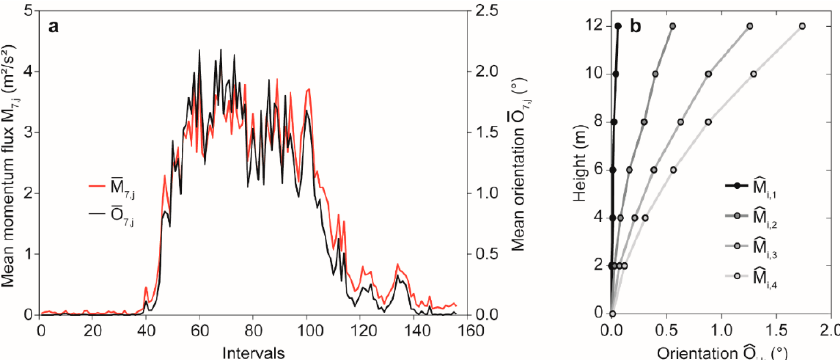
Figure 4. ( a ) Mean momentum flux at canopy height ( 𝑀(cid:3365) (cid:2875),(cid:2920) ) and mean orientation at ℎ (cid:2875) = 12 m ( 𝑂(cid:3364) (cid:2875),(cid:2920) ) in 156 irregular intervals on 30 January 2019; ( b ) mean orientation ( 𝑂(cid:3552) (cid:2919),(cid:2921) ) at ℎ (cid:2869) = 0.1 m to ℎ (cid:2875) = 12 m in four classes of mean momentum flux calculated at canopy height ( 𝑀(cid:3553) (cid:2919),(cid:2869) : 𝑀(cid:3365) (cid:2919),(cid:2920) < 1.0 m²/s², 𝑀(cid:3553) (cid:2919),(cid:2870) : 1.0 m²/s² ≤ 𝑀(cid:3365) (cid:2919),(cid:2920) < 2.0 m²/s², 𝑀(cid:3553) (cid:2919),(cid:2871) : 2.0 m²/s² ≤ 𝑀(cid:3365) (cid:2919),(cid:2920) < 3.0 m²/s² and 𝑀(cid:3553) (cid:2919),(cid:2872) : 𝑀(cid:3365) (cid:2919),(cid:2920) ≥ 3.0 m²/s²).